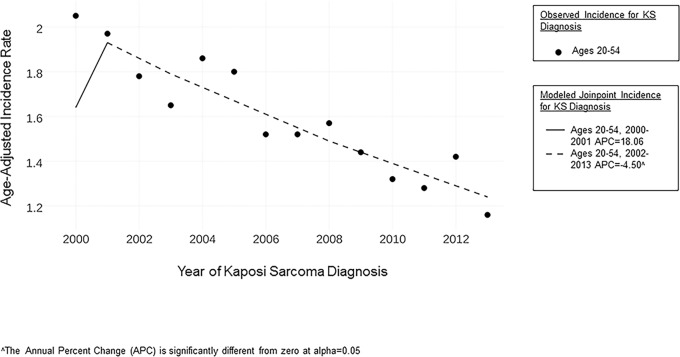
KS incidence in the U.S., 2000–2013, N = 4,455.